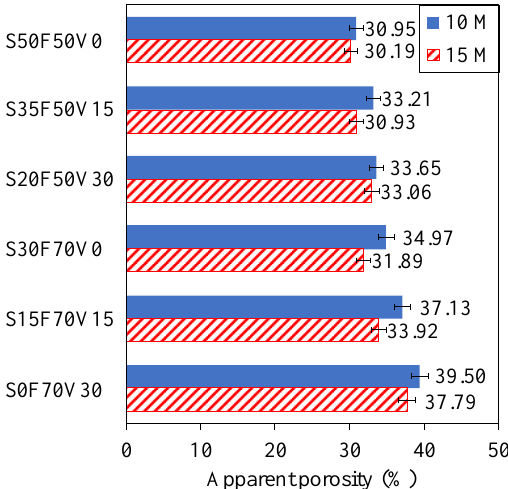
Figure 5. Apparent porosities of the geopolymer mortar.